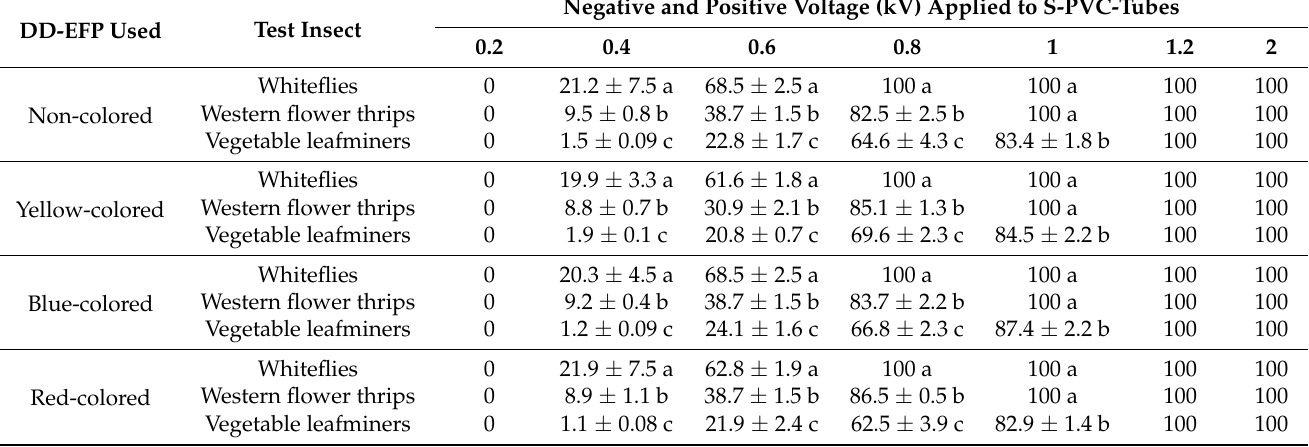
Table 1. Percentages of test insects captured by oppositely electrified soft polyvinyl chloride (S-PVC) tubes of the double- charged dipolar electric field producer (DD-EFP) containing charged water with and without